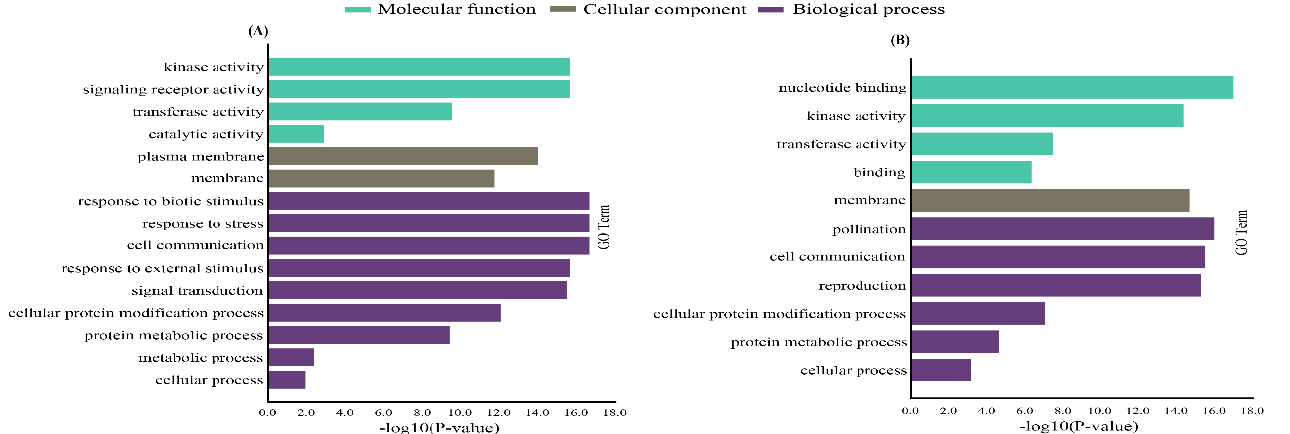
Figure 4. Gene ontology-based enrichment analysis of ( A ) L-type LecRLK and ( B ) G-type LecRLK proteins in cucumber. The proteins are functionally characterized into molecular function (green bars), cellular component (grey bar), and biological process (purple bars).